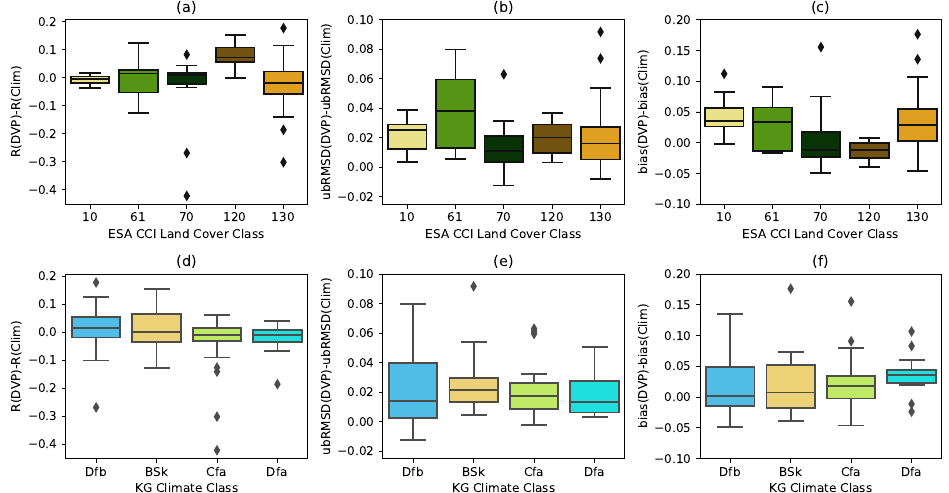
Figure 7. Box plot of the difference in the Pearson correlation coefficient (R), unbiased RMSD and bias between in situ soil moisture and soil moisture retrieved using vegetation parameters derived using dynamic vegetation parameters ( λ = 21 days) and those derived from climatological values. Data are binned by ESA CCI Land Cover Class ( a – c ) and Köppen–Geiger Climate Class ( d – f ). The box extends from the lower to upper quartile values of the data, with a line at the median. The lower whisker is at the lowest datum above Q1 − 1.5 ∗ (Q3 − Q1) and the upper whisker at the highest datum below Q3 + 1.5 ∗ (Q3 − Q1), where Q1 and Q3 are the first and third quartiles. Outliers are indicated as